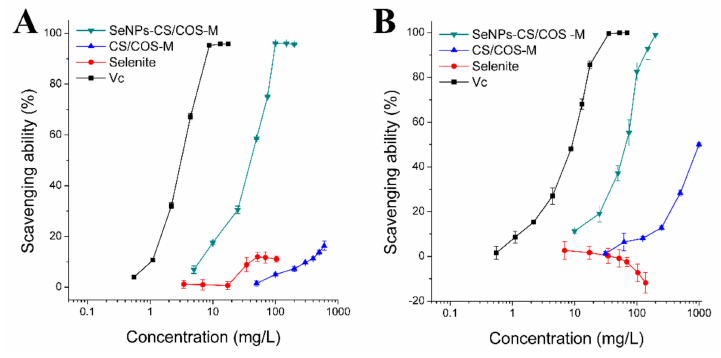
Figure 4. Free radical scavenging abilities against ( A ) DPPH ( • DPPH) and ( B ) superoxide anion ( • O 2 − ) radicals. SeNPs-CS / COS-Ms containing 15 mg Se / kg (CS:COS = 10:90) and CS / COS-Ms (CS:COS = 10:90) were evaluated in this